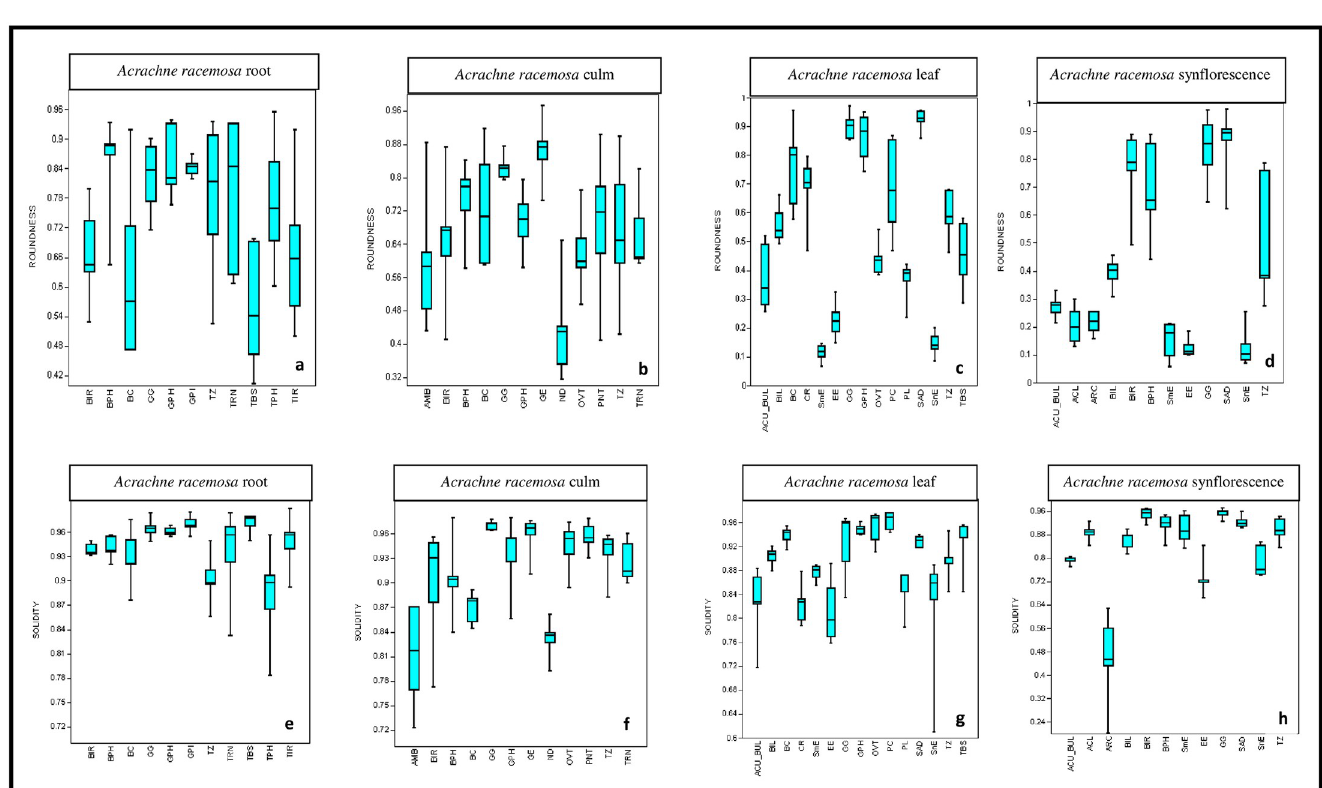
Fig 8. Box-Whisker plots for median percentile and range of shape descriptors (roundness and solidity) of phytoliths in Acrachne racemosa (Heyne ex Roem. & Schult.) Ohwis.